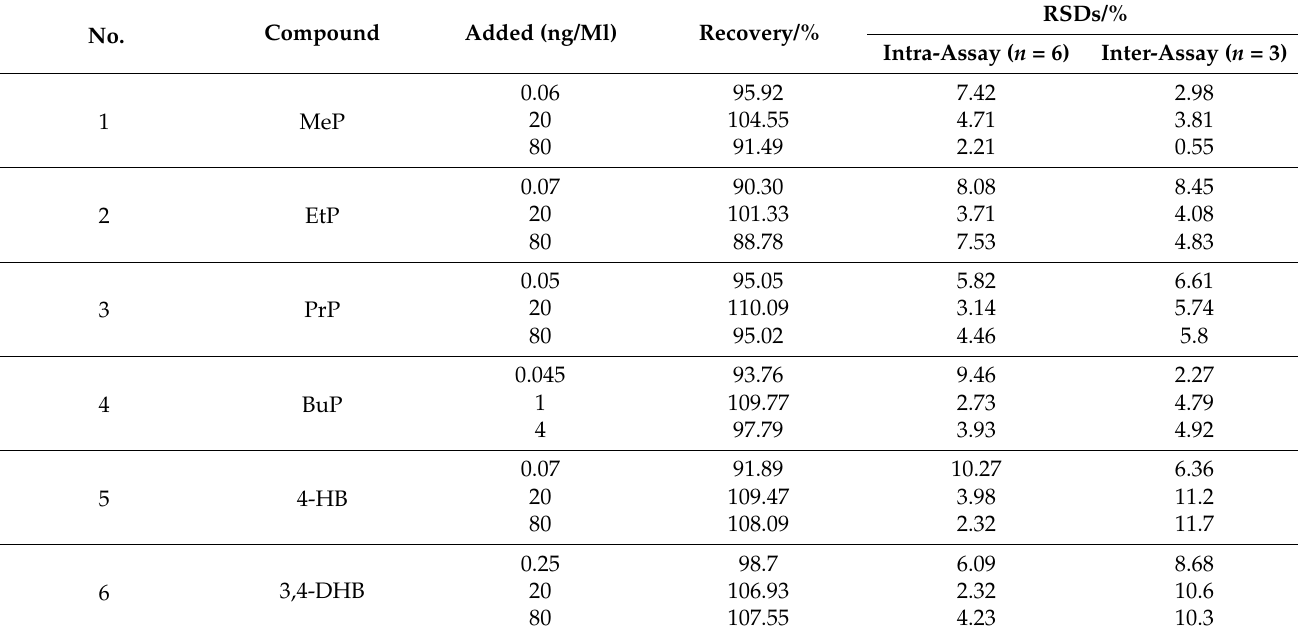
Table 3. Spiked recoveries and RSDs of the detected compounds at 3 levels in seminal plasma.